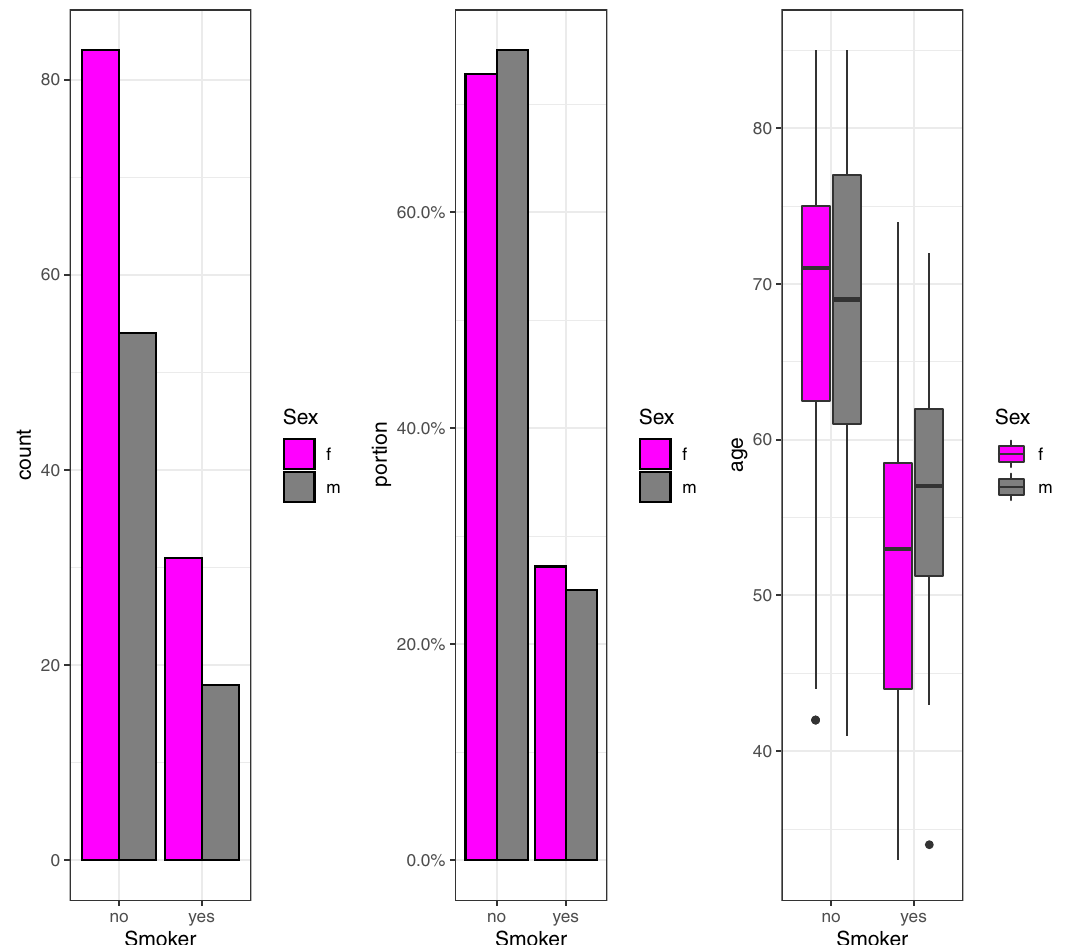
Figure 1: Number of female and male smokers ( left and middle panels ) and age distribution of smokers and non - smokers ( right panel )